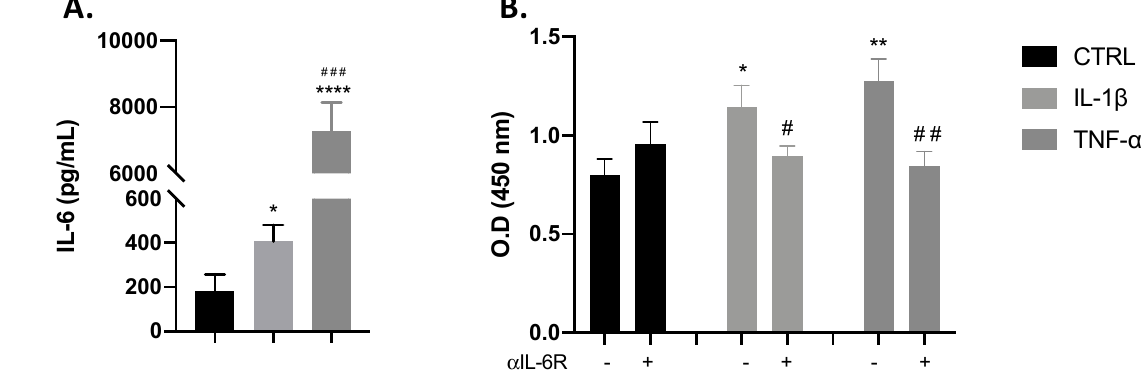
Figure 1. Interleukin (IL)-1 β and tumour necrosis factor (TNF)- α effects in proliferation are dependent on IL-6 production. Bar chart shows the effect of control (black), IL-1 β (gray), and TNF- α (dark gray) on myoblast IL-6 production and proliferation. ( A ) IL-1 β and TNF- α significantly increased IL-6 release. ( B ) IL-1 β and TNF- α significantly increased the incorporation of BrdU, which was reduced with IL-6R α blocking. Data are shown as mean ± SEM (* p < 0.05, ** p < 0.01, and **** p < 0.0001 vs. control from unpaired t -test; # p < 0.05, ## p < 0.01 and ### p < 0.001 vs. IL-1 β and TNF- α both from unpaired t -test).